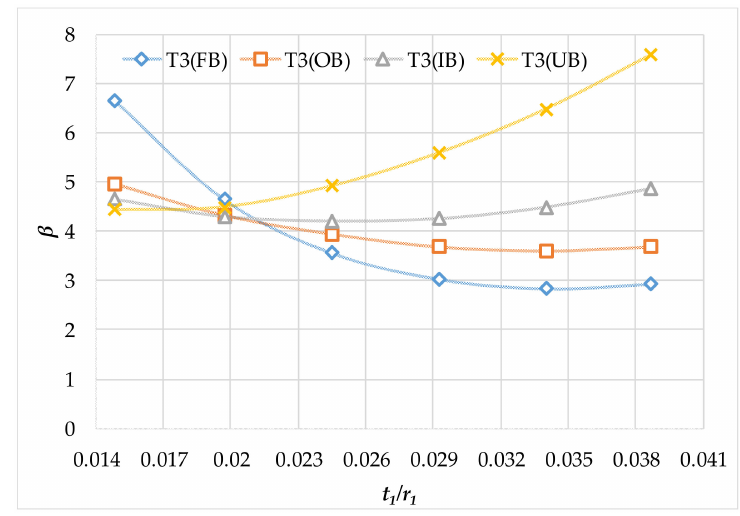
Figure 10. β as a function of outer pipe thickness ( t 1 /r 1 ).